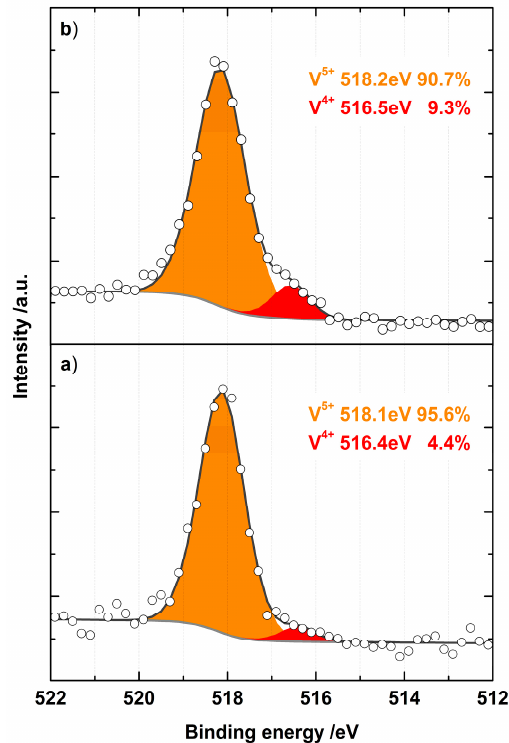
Figure 3. V 2p 3/2 core-level spectra of a V 2 O 5 single crystal ( a ) immersed in LiPF 6 in EC/DMC electrolyte and ( b ) the same crystal after cleaning in EtOH and drying in air. Open circles represent experimental data and the black line is the envelope of the fitted curve.